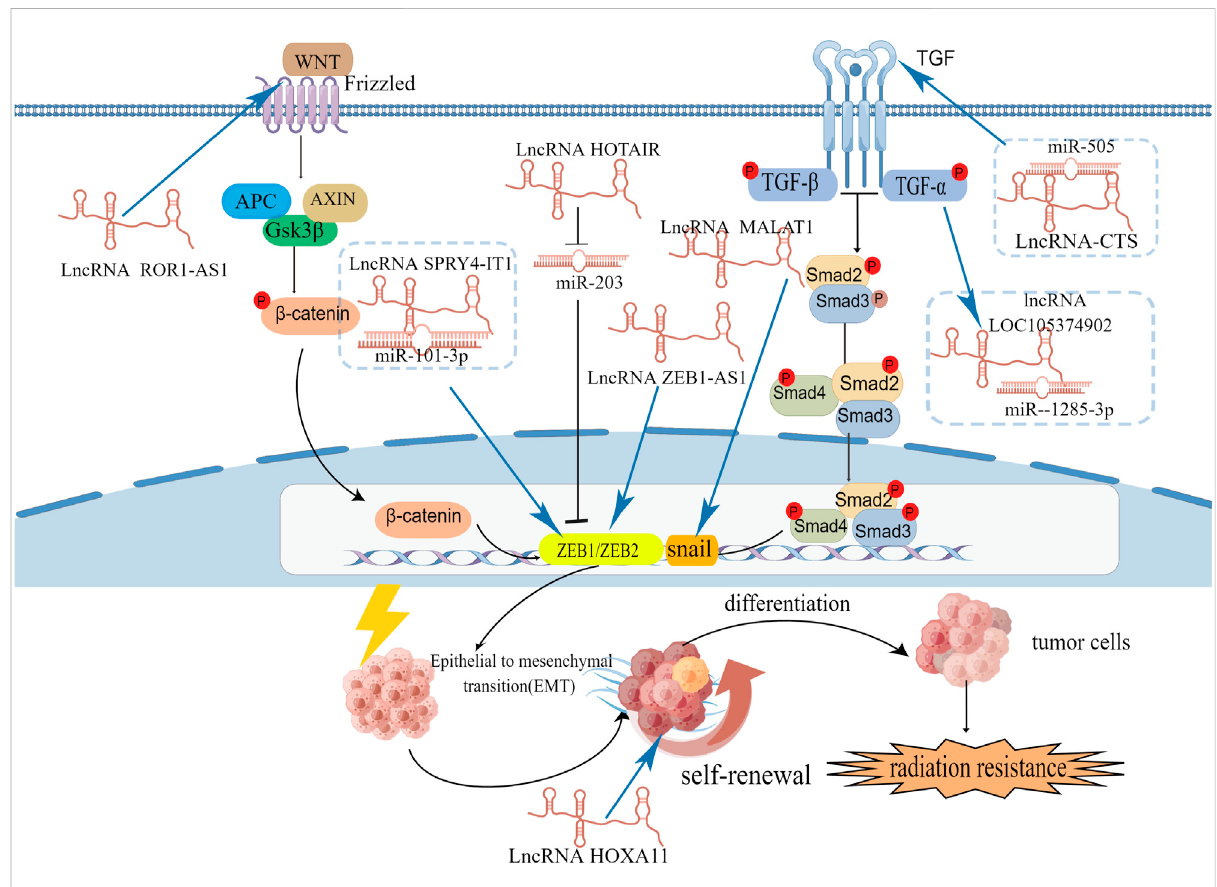
FIGURE 4 The signaling pathways and EMT-related transcription factors involved in lncRNAs and